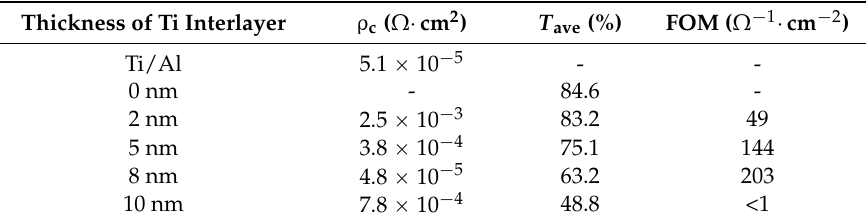
Figure 6. Optical transmittance of the Ti/ITO ‐ ZnO systems as a function of the Ti interlayered thickness (the optical transmittance of the pure ITO ‐ ZnO also is shown for comparison). Table 2. Specific contact resistance, optical average transmittance, and FOM of the Ti/ITO ‐ ZnO systems as a function of the thickness of the Ti interlayer (the specific contact resistance of the TI/Al contact to the n ‐ GaN epilayer also is given for comparison).